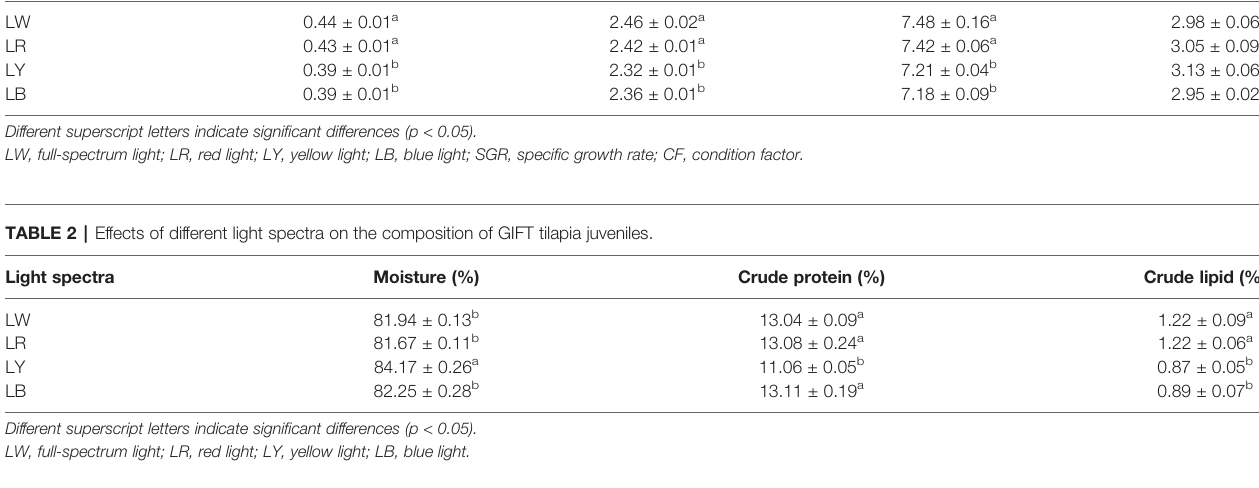
TABLE 1 | Growth indices of GIFT tilapia juveniles cultured under different light spectra. Light